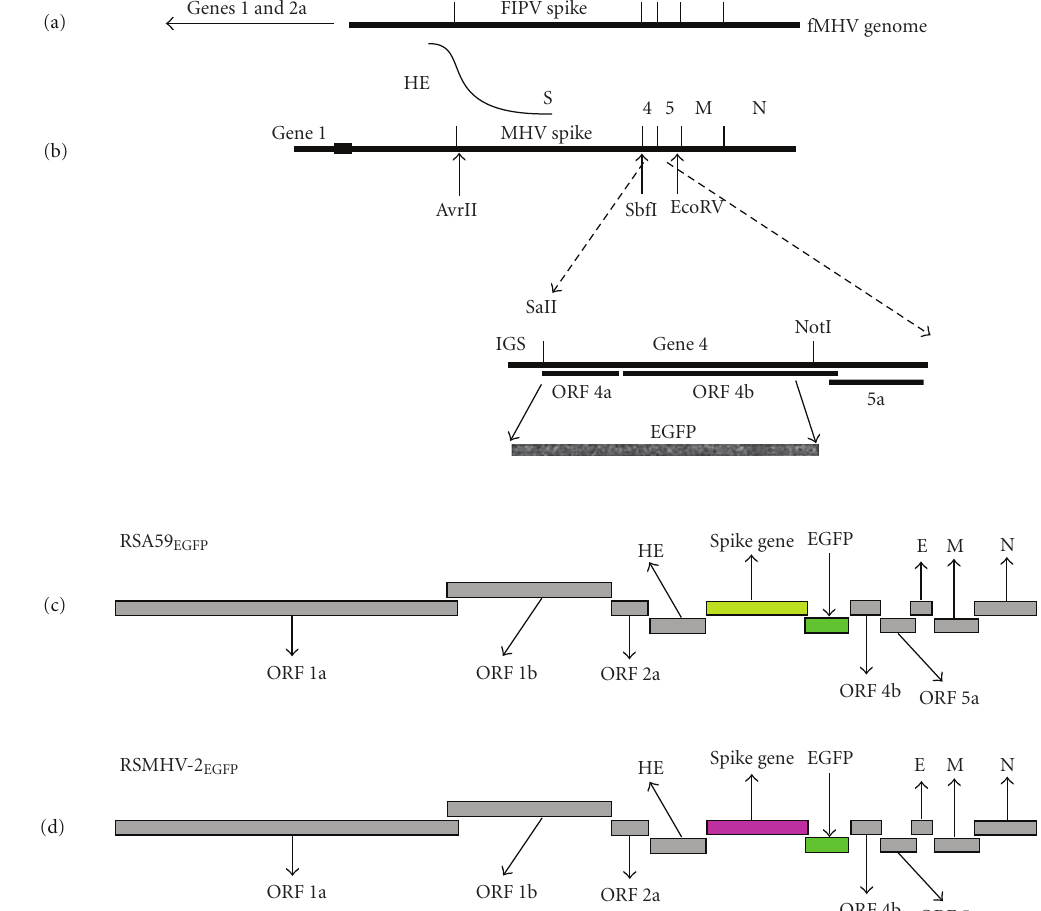
Figure 10: Schematic representation of targeted recombination to construct EGFP-expressing MHVs. The replacement of ORFs 4a and 4b with the EGFP gene was carried out by using recombinant technology, as described previously in [114]. (a) a schematic of the fMHV genome; it encodes the ectodomain of the feline infectious peritonitis spike in the background of the A59 genome. (b) shows the synthetic RNA transcribed from the vector pMH54 EGFP (MHV-A59 S gene) or pMHV-2 EGFP (MHV-2 S gene) [81, 114]. The curved line between the genome and the pMH54 RNA indicates the region in which the crossover must have occurred. The restriction sites relevant to the introduction of the EGFP gene are shown. The enlargement of the gene 4 region shows the modifications in which most of ORFs 4a and 4b are replaced by the enhanced green fluorescent protein (EGFP) gene. The IGS (intergenic sequence) is the site of initiation of transcription of mRNA 4. (c) and (d) show the resulting EGFP-expressing viruses: (c) RSA59 EGFP expressing the MHV-A59 S gene and (d) RSMHV2 EGFP expressing the MHV-2 S gene. (adapted from the work of [114]).